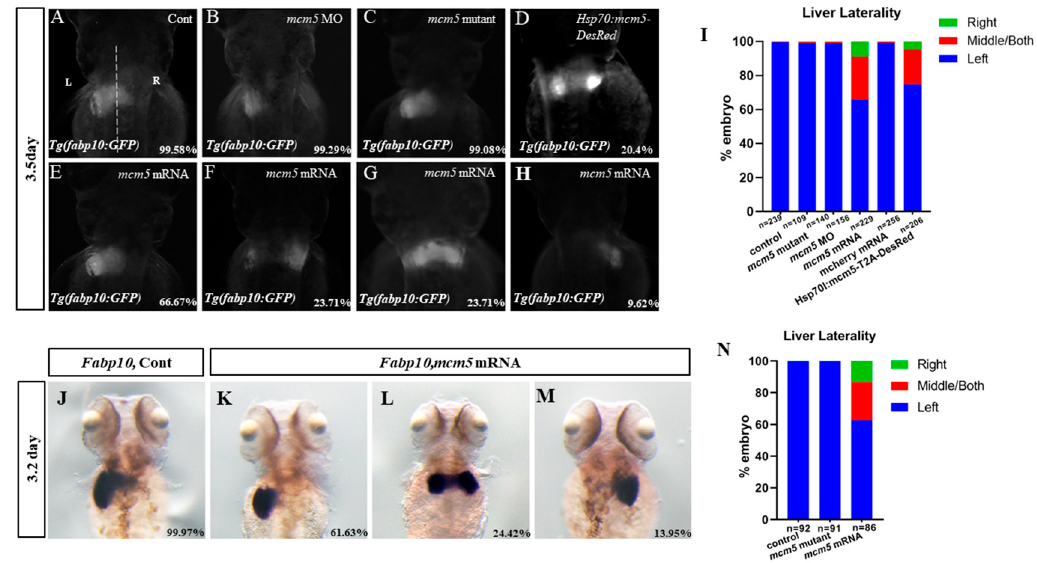
Figure 1. MCM5 overexpression, but not loss of function, leads to liver bifida. ( A – I ) In our observations, 99.58% of the Tg(lfabp10:GFP) control embryos displayed a left-sided liver ( A , I , n = 293). In the mcm5 morphants or mcm5 mutants, the liver became mildly smaller ( B , C ) than that in the control embryos; 99.29% of the mcm5 morphants ( B , H , n = 140, p > 0.05) and 99.08% of the mcm5 mutants ( C , I , n = 103, p > 0.05) displayed a left-sided liver. In embryos with a forced expression of mcm5 , the proportions of embryos with a left-sided liver, liver bifida, and a right-sided liver were 66.67% ( E , I , n = 156, p = 0.00025), 23.71% ( F , G , I , n = 156, p = 0.0026), and 9.62% ( H , I , n = 156, p = 0.0064), respectively. Similarly, in embryos with a forced expression of mcm5 by heat-shock at 40% epiboly, the proportion of embryos with liver bifida and a right-sided liver was increased when compared with the control embryos ( D , I , n = 206, p = 0.0035). In total, 97.4% of the embryos injected with mCherry mRNA displayed a left-sided liver ( I , n = 229, p = 0.35). ( J – N ) In the wild-type embryos, the rate of left-sided expression of lfapb10 was 99.97% ( J , N , n = 92), while 99.89% of the mcm5 mutants displayed left-sided expression of lfabp10 ( J , n = 91, p = 0.93). In total, 61.63% ( K , N , n = 86, p = 0009), 24.42% ( L , N , n = 86, p = 0.0006), and 13.95% ( M , N , n = 86, p = 0.0017) of embryos injected with mcm5 mRNA displayed a left-sided, both-sided, and right-sided expression of lfabp10 ,